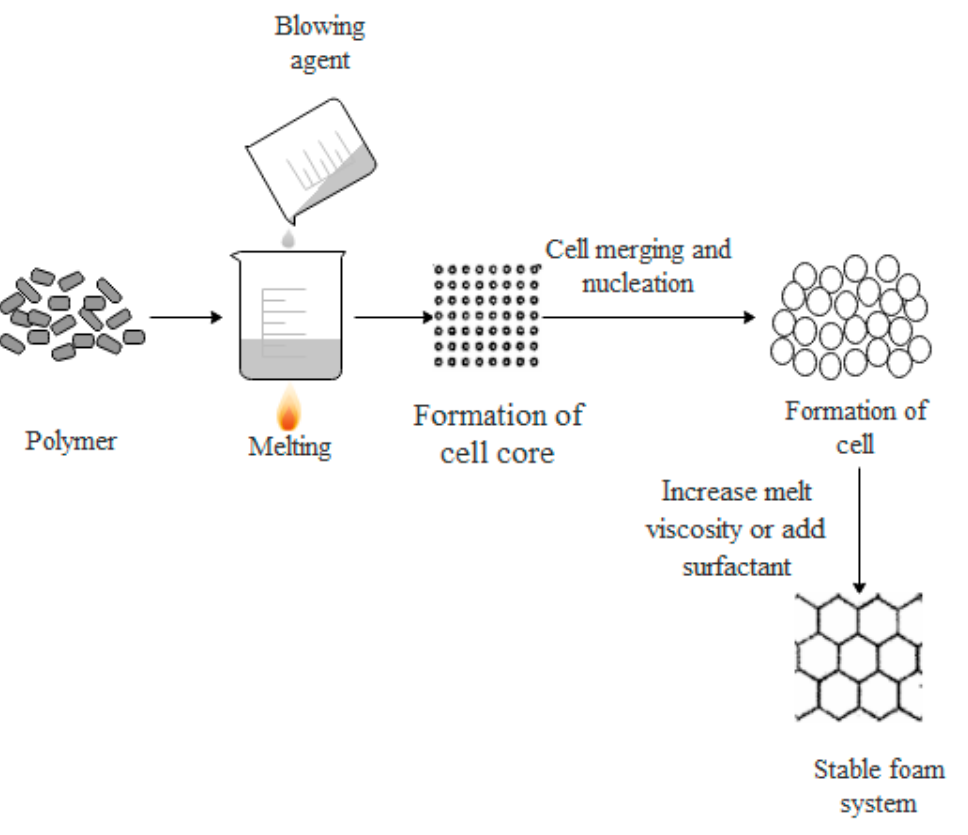
Figure 1. Schematic diagram of the foaming process.